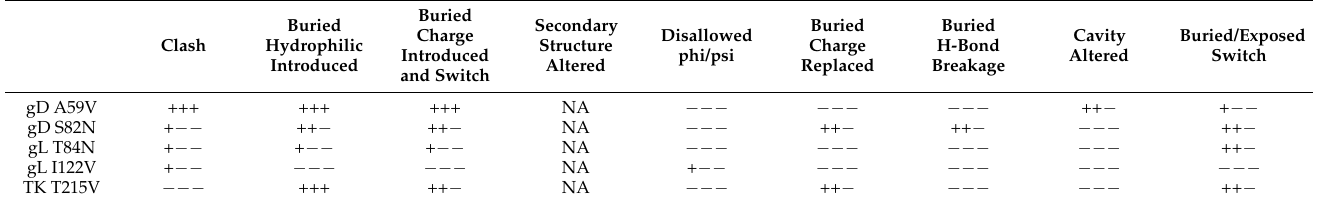
Table 2. Mutation analysis of PRV gD, gL, and TK protein domains between Bartha and JL-CC